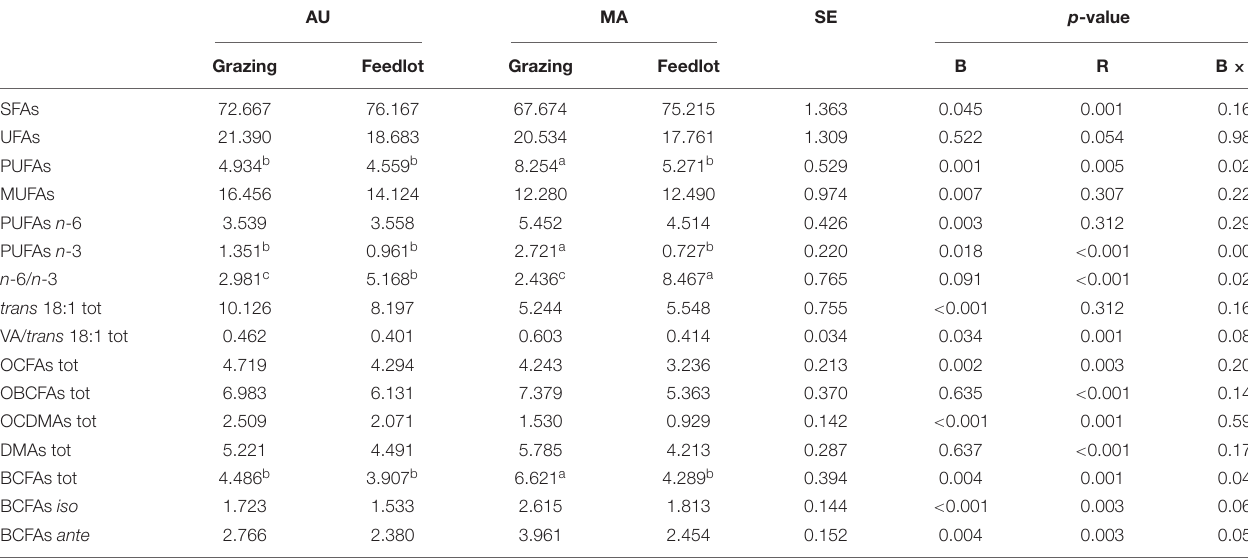
TABLE 1 | Relative percentage (g/100 g of total FAs + DMAs) of the main classes of fatty acids and dimethyl acetals in the rumen liquor from Aubrac or Maremmana steers maintained in feedlot or on pasture. AU MA SE p -value Grazing Feedlot Grazing Feedlot B R B × R